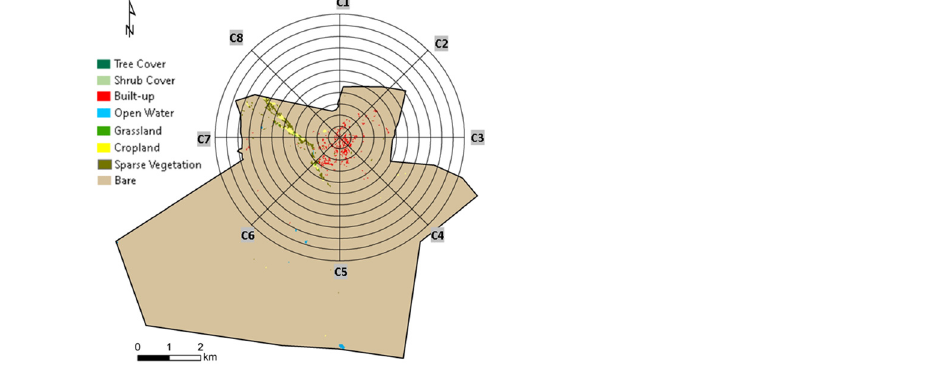
Figure 14. Surface temperature cross section along a northeast-southwest transect across the city of Smara.